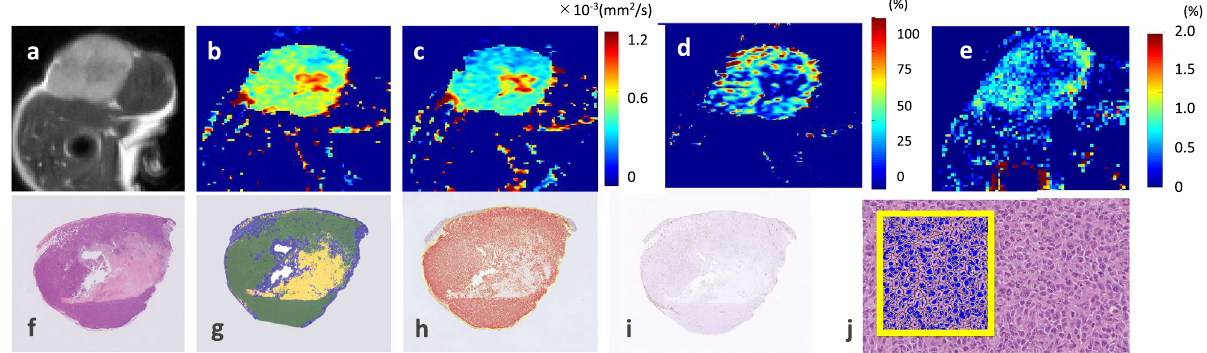
Figure 7. Representative case of MDA-MB-231 tumor. MR images: ( a ) T2WI, ( b ) sADC map (diffusion time, T d = 9 ms), ( c ) sADC map (T d = 27.6 ms), ( d ) ΔsADC 200–1500 map, ( e ) APT imaging map, and whole tumor histological images: ( f ) H&E staining, ( g ) cellular area map, ( h ) Ki-67-positive cell map, ( i ) CD31 staining. ( j